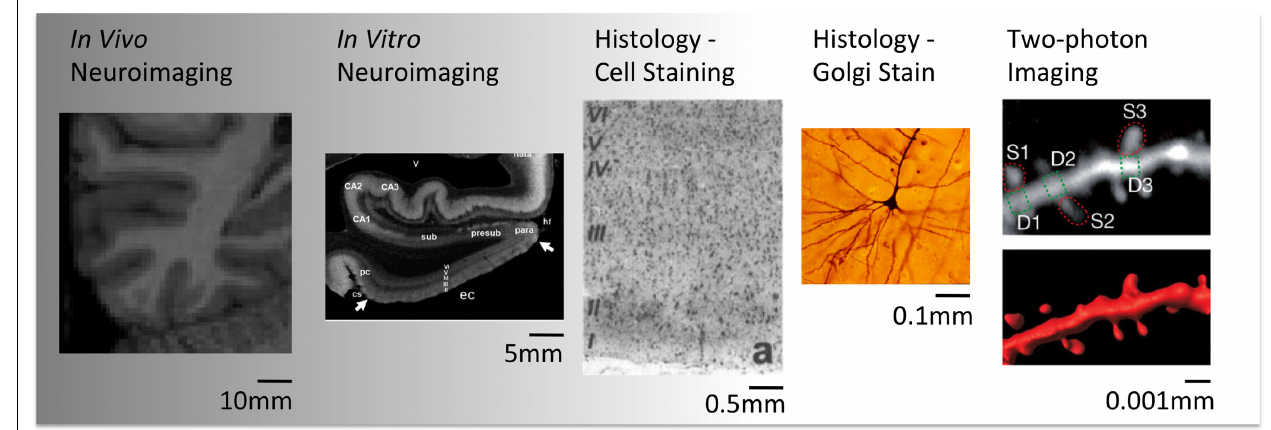
FIGURE 1 | Illustration of different spatial scales provided by different techniques (Pictures reproduced with permission. Credits:Wikimedia Commons,Arnold and Rioux, 2001; Chen et al., 2011).